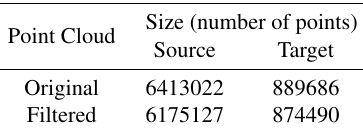
Figure 3. Registration results of two scans of the construction site. (a) and (d) Original scans. (b) and (e) 2D projection images. (c) and (f) Magnitude images of FFT in log-polar space. The above figures are results from the target scan, and the below figures are from the source scan.